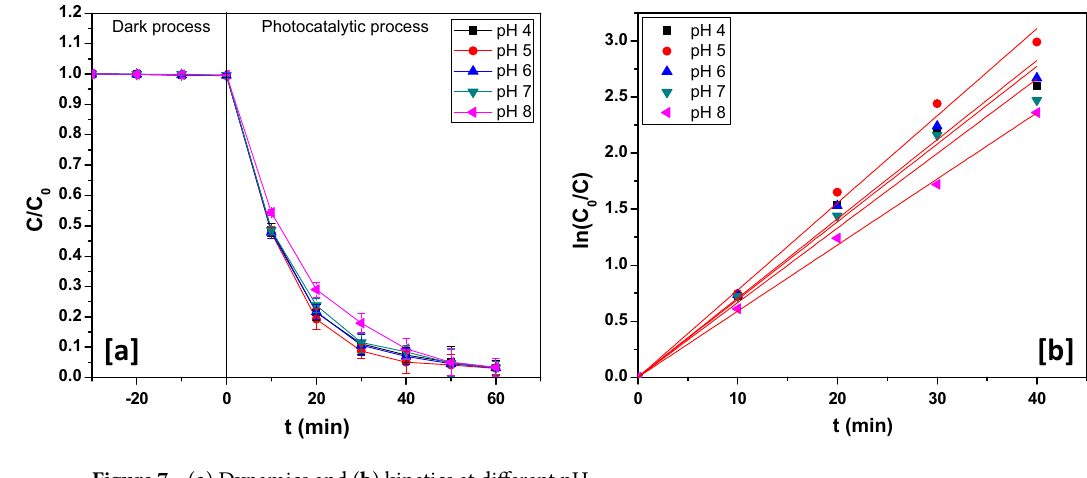
Figure 7. ( a ) Dynamics and ( b ) kinetics at different